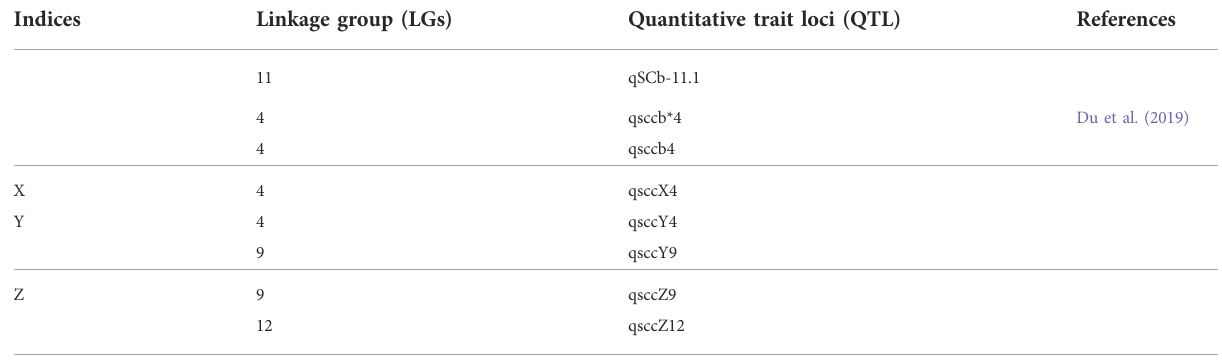
TABLE 8 Detailed information on 14 QTLs responsible for the charcoal-rot disease resistance gene in sesame.